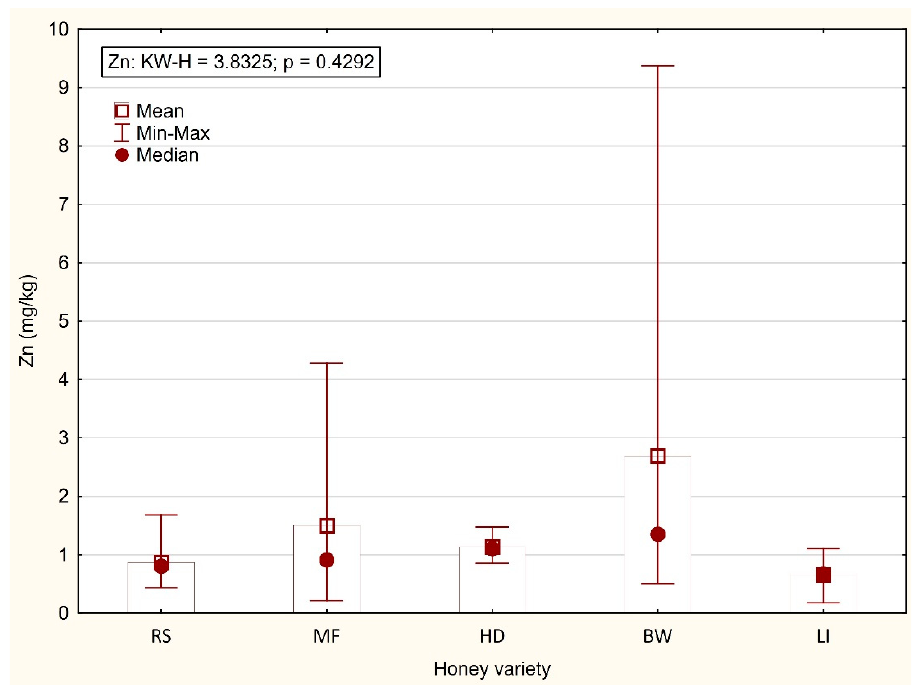
Figure 3. Content of Zn (mg/kg) in varietal honeys (RS—rapeseed; MF—multifloral; HD—honeydew; BW—buckwheat; LI—linden).